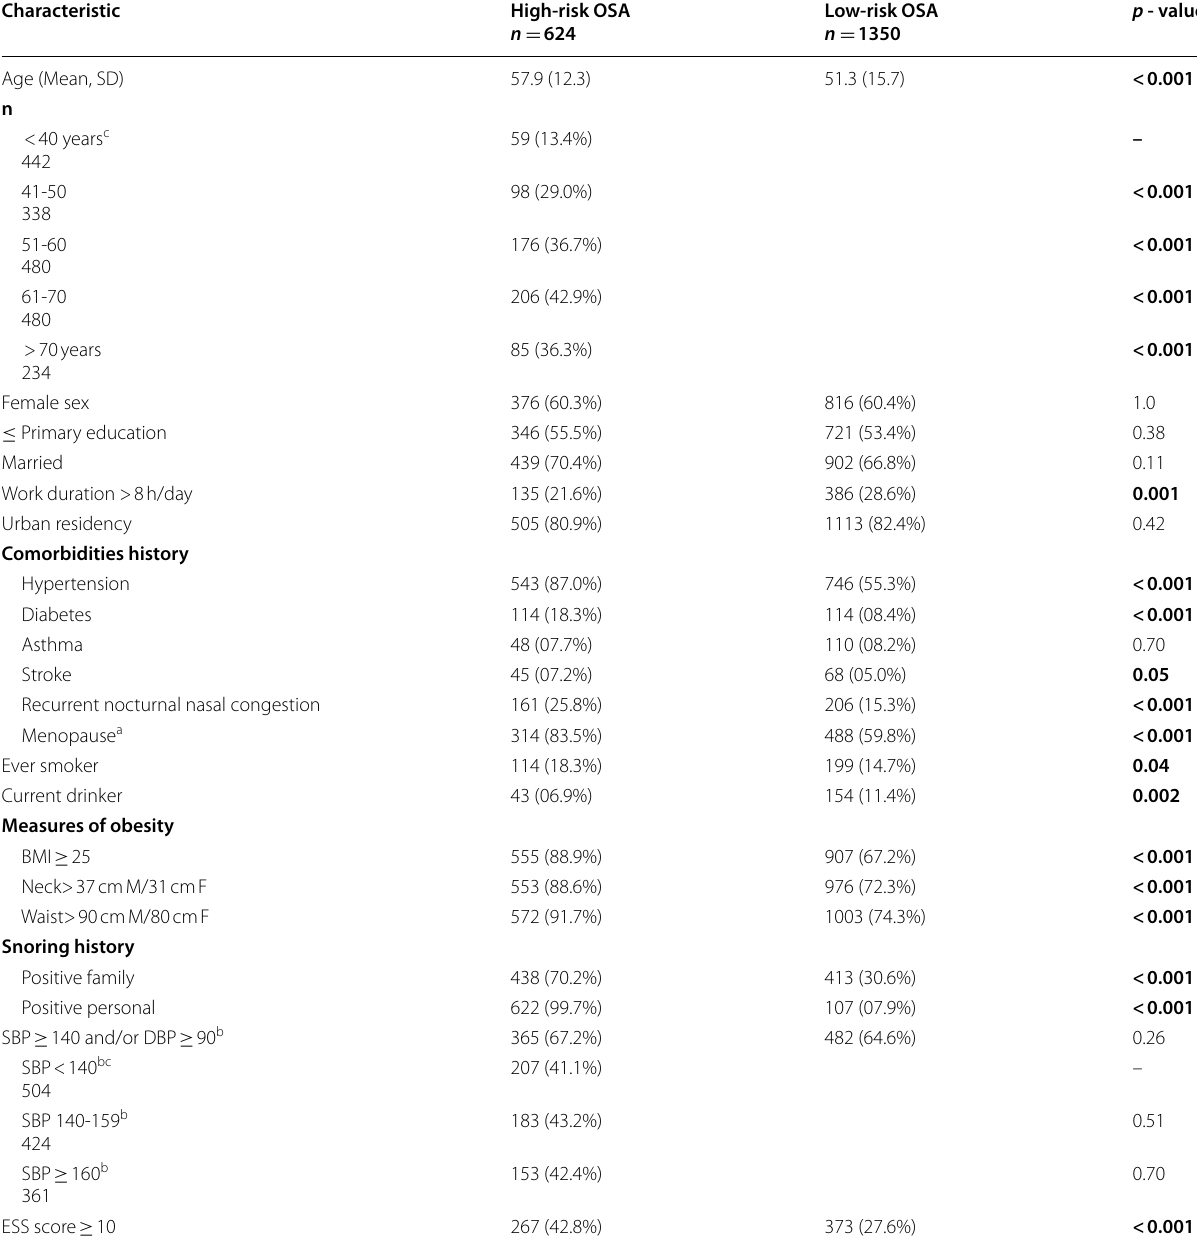
Table 3 Sociodemographic and Clinical characteristics comparison by OSA status